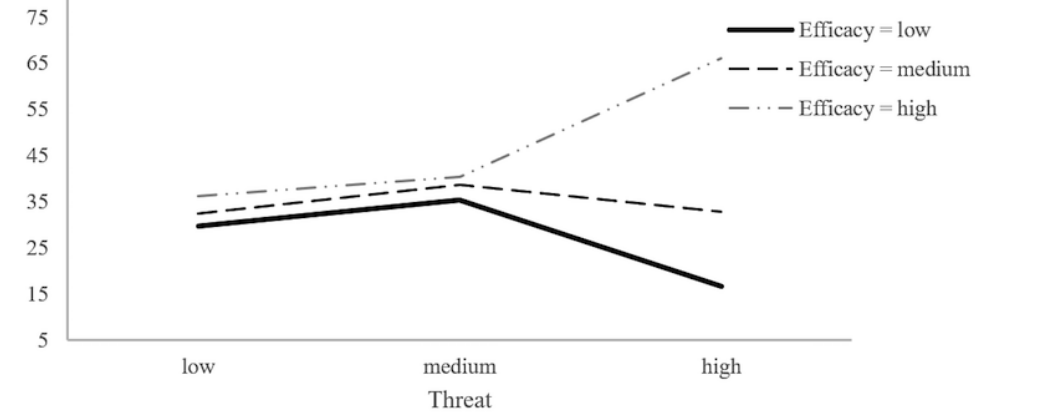
Figure 2. Interaction effect between threat and efficacy upon the number of